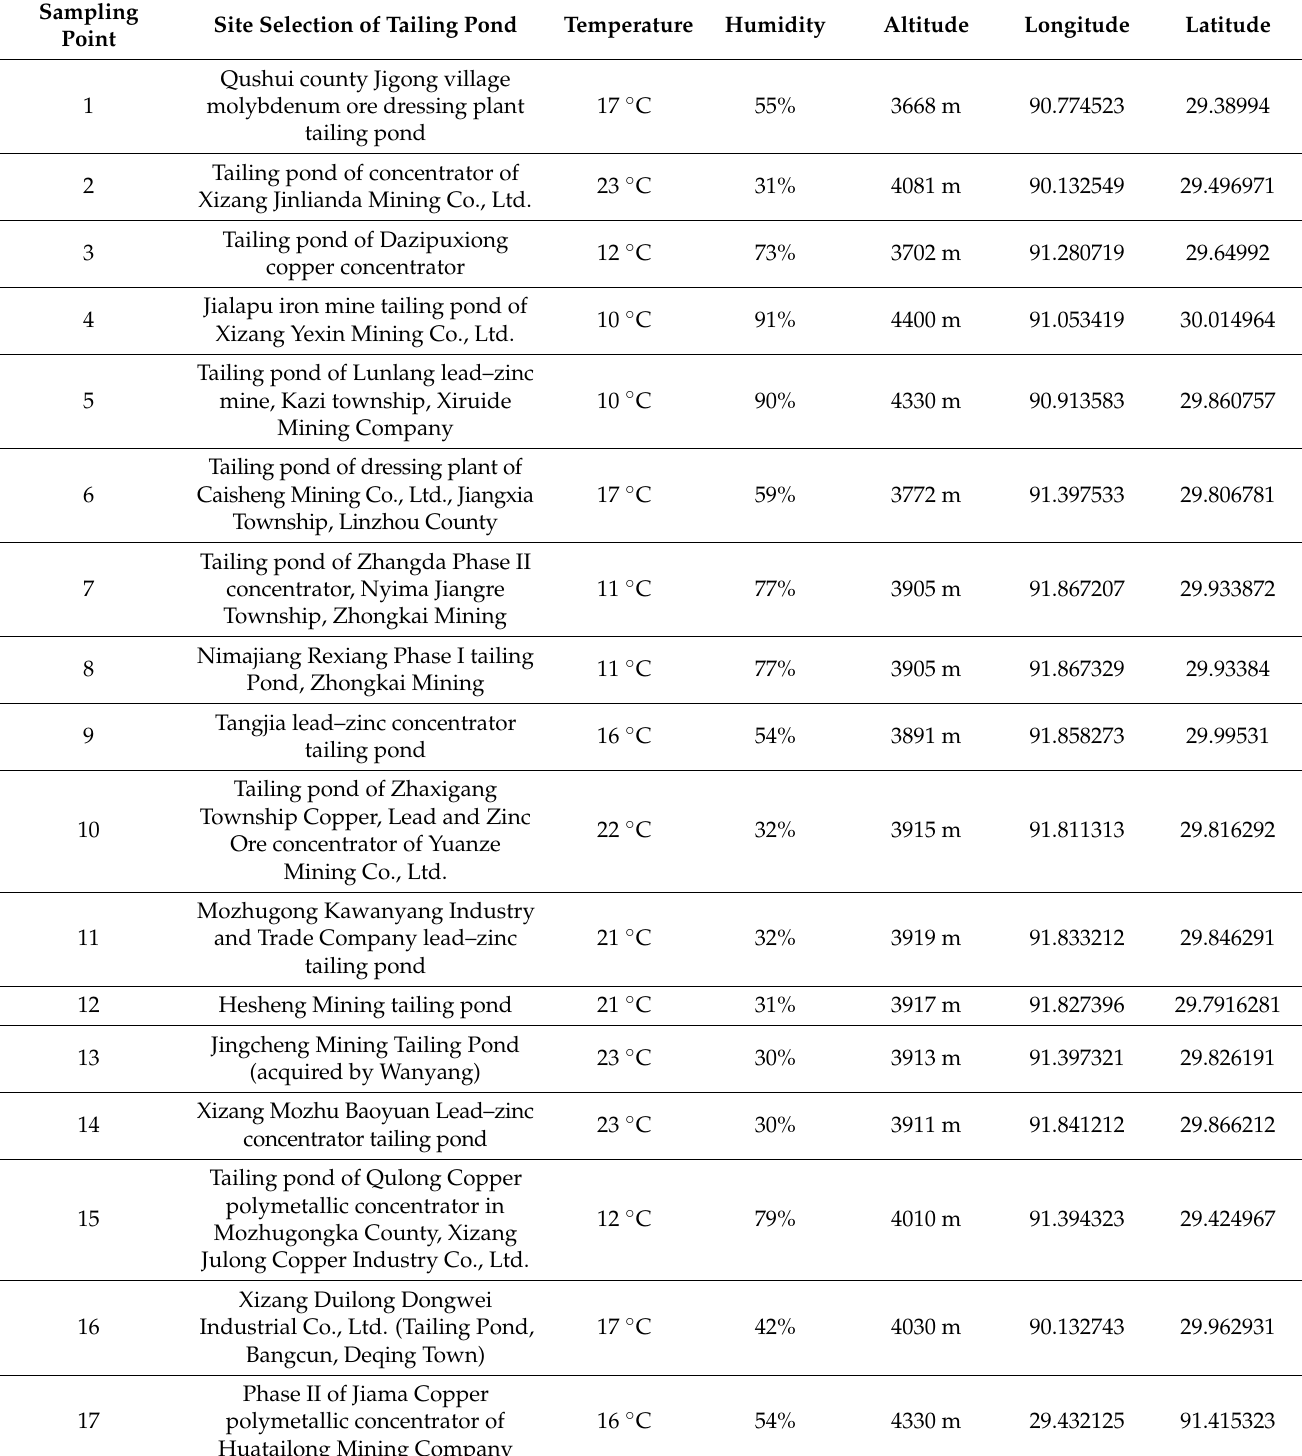
Table 1. Specific mining situation of metal tailing sampling sites in Lhasa,